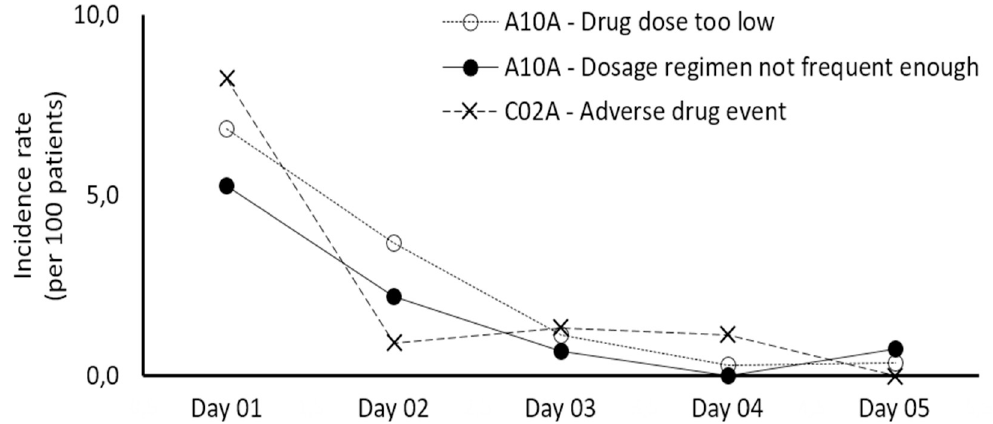
Fig 1. Distribution of the incidence of causes of Drug-Related Problems (DRPs) associated with the prescription of insulins (A10A) and centrally acting antihypertensives (C02A) in the first five days of hospitalization. Legend: A10A - insulins and analogues, C02A - centrally acting antiadrenergic agents.